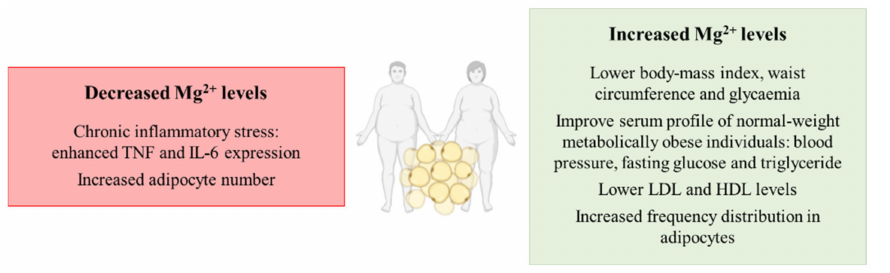
Figure 2. Schematic representation of the contribution of decreased and increased magnesium levels to the development of overweight or obesity. Abbreviations: TNF: tumor necrosis factor; IL-6: interleukin-6; LDL: low-density lipoprotein; HDL: high-density